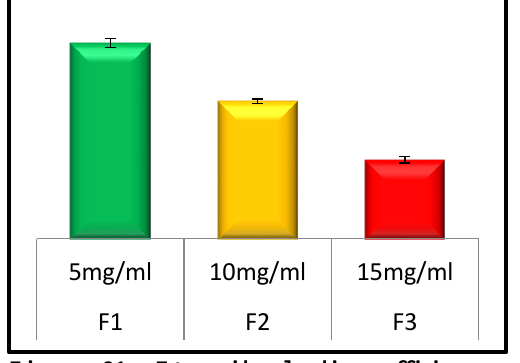
F2 F3 Figure 21. Etoposide loading efficiency of etoposide-loaded gold nanoparticles formula F1 (values are represented as mean% ± SD). Average particles size: 22.74nm